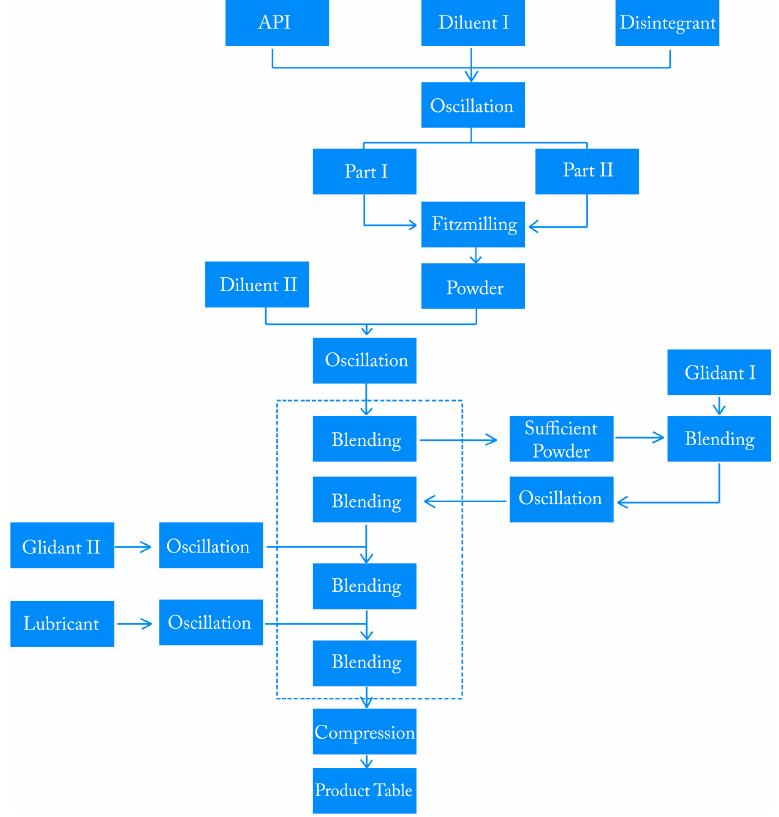
Figure 1. Baseline pharmaceutical tablet processes block diagram.